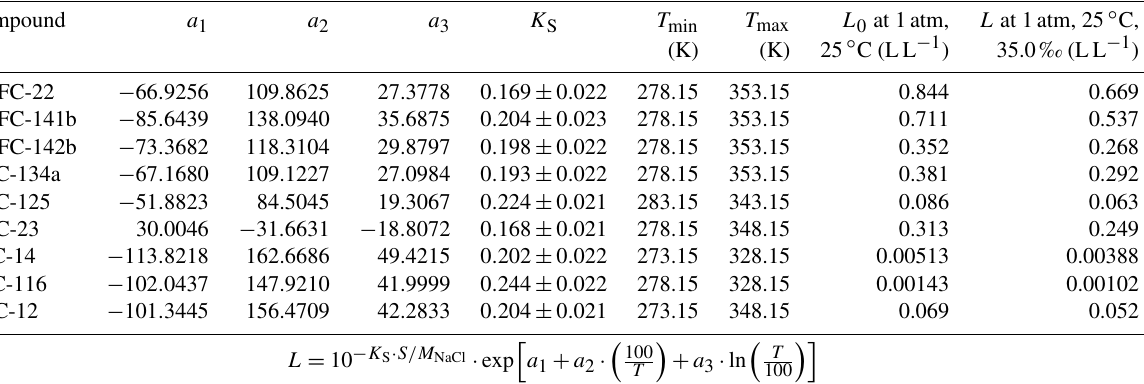
Table 5. Ostwald solubility coefficients of HCFC-22, HCFC-141b, HCFC-142b, HFC-134a, HFC-125, HFC-23, PFC-14, PFC-116 and CFC-12 in seawater estimated based on the combined